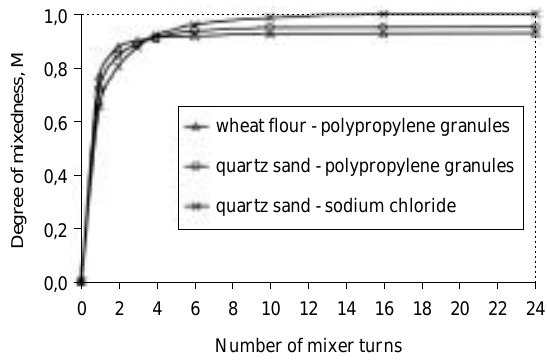
Fig. 3 Kinetic curves obtained by the mixer shown in Figure 2 with extreme particle systems (particle sizes, densities, and their ratios are given in Tables 1 and 2